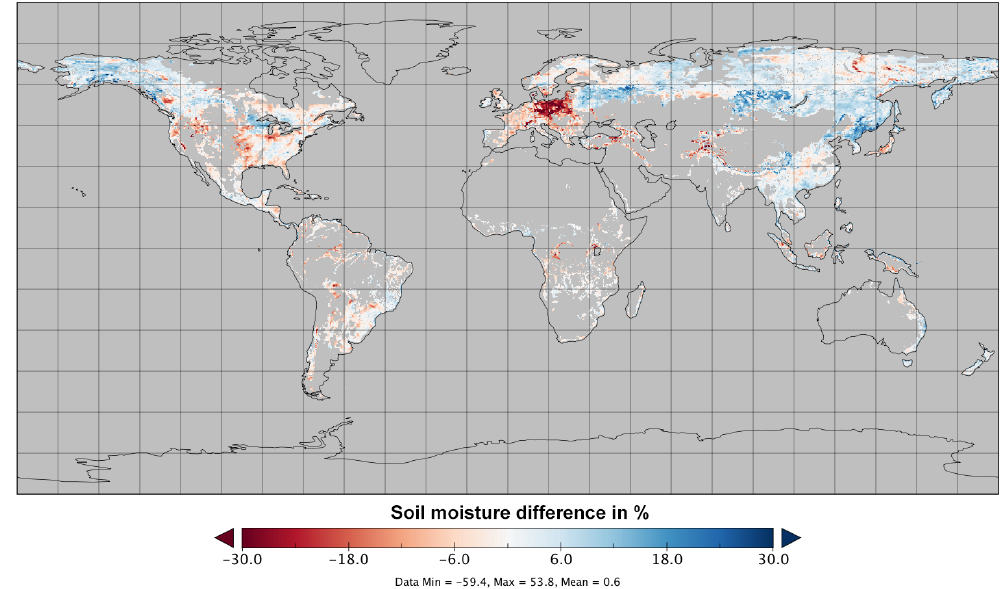
Figure C1. Absolute differences in soil moisture for ASCAT (ASCAT NRT minus ASCAT offline) for the entire year 2013 (masked according to the blending map in Fig. 4).